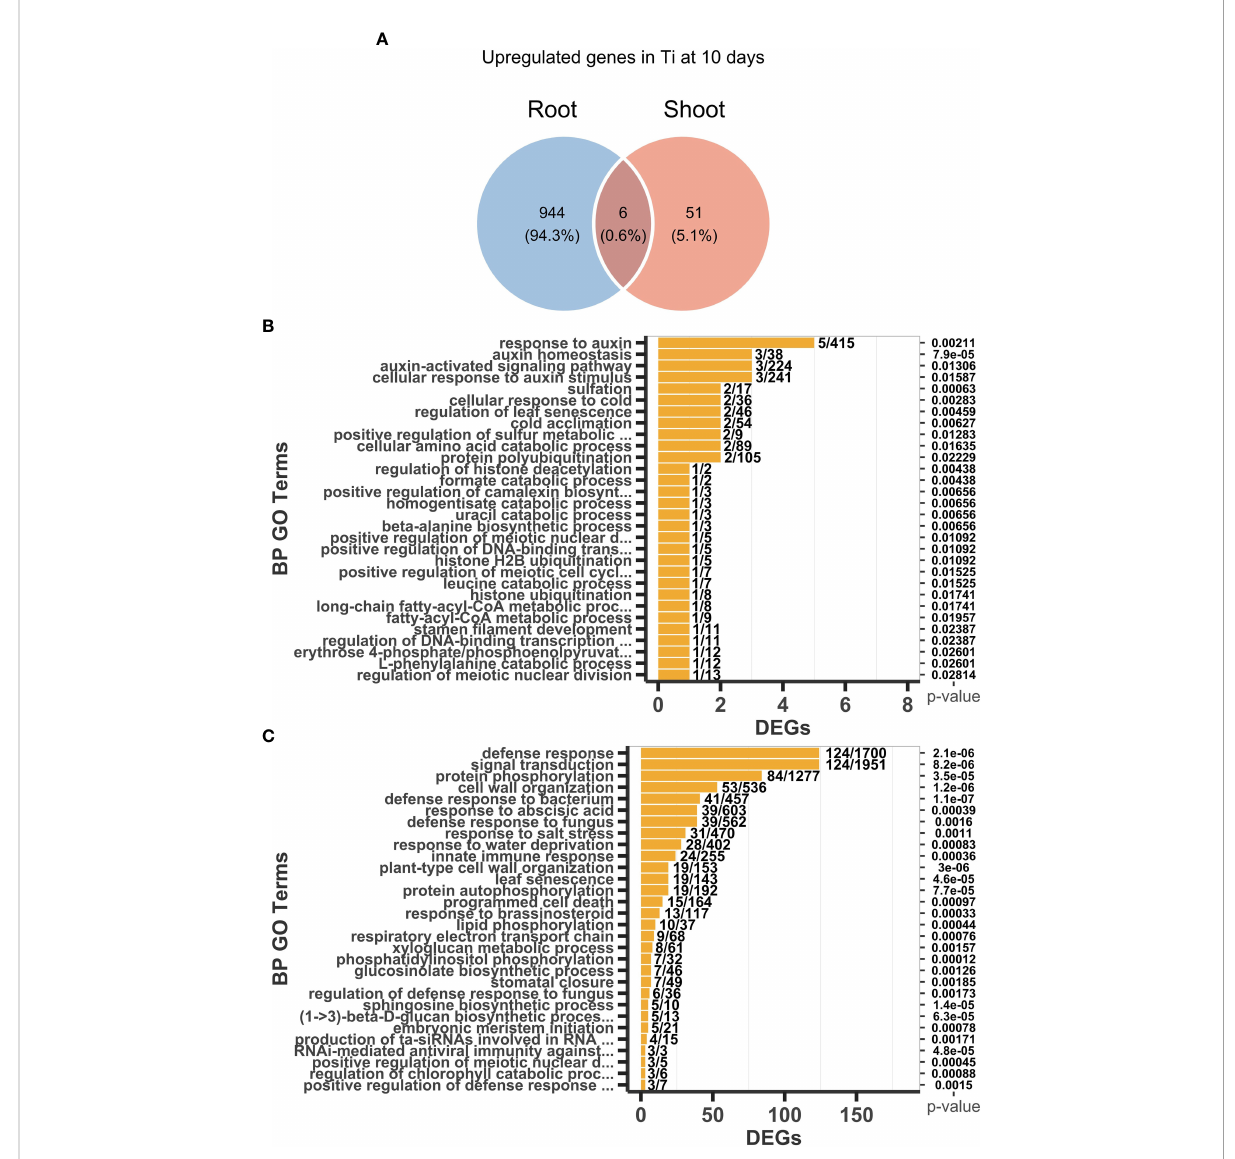
FIGURE 4 Transcriptomic responses and enriched Gene Ontology (GO) categories of differentially expressed genes (DEGs) in response to Titanium (Ti) in Arabidopsis. (A) Shared upregulated DEGs between roots and shoots. Top 30 enriched GO categories of upregulated DEGs in roots (B) and shoots (C) in response to Ti